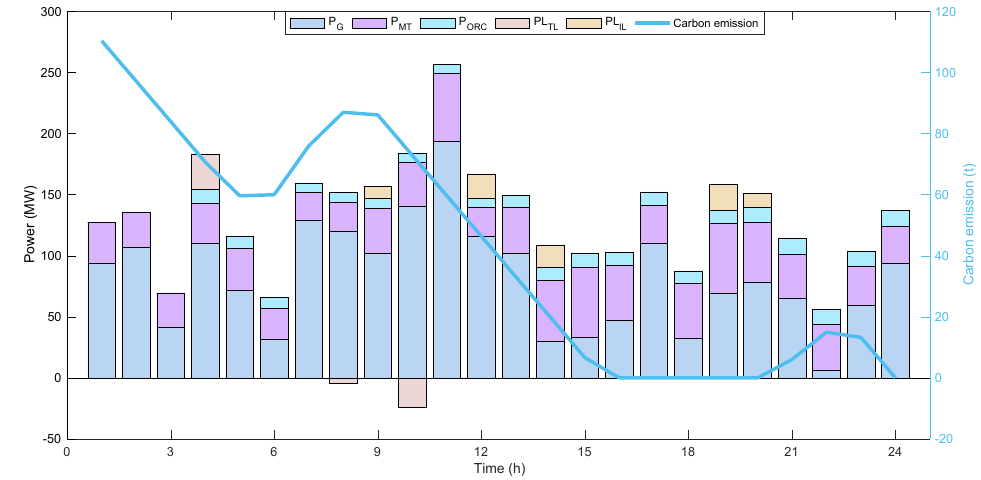
Figure 10. Power supply and consumption of the